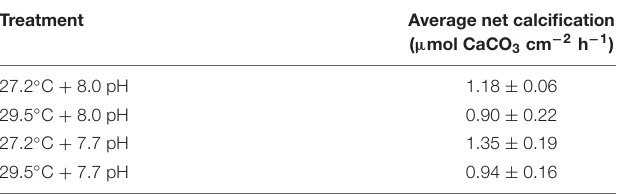
FIGURE 2 | Relative change in average O 2 produced by fragments of Porolithon cf. onkodes from mean, respective acclimation treatment temperature, panel (A) acclimated at 27.2 ◦ C for 6 weeks, (B) acclimated at 29.5 ◦ C for 6 weeks. O 2 begins at “0” or the starting average O 2 per acclimation temperature. Each point is the mean, relative change of O 2 ± standard error (SE) for each treatment at each ramp temperature. n = 4–5. Blue points equate to control temperature, 27.2 ◦ C, and yellow hued points to elevated temperature, 29.5 ◦ C, with pH treatment shown as different shades and shapes within temperature treatment.